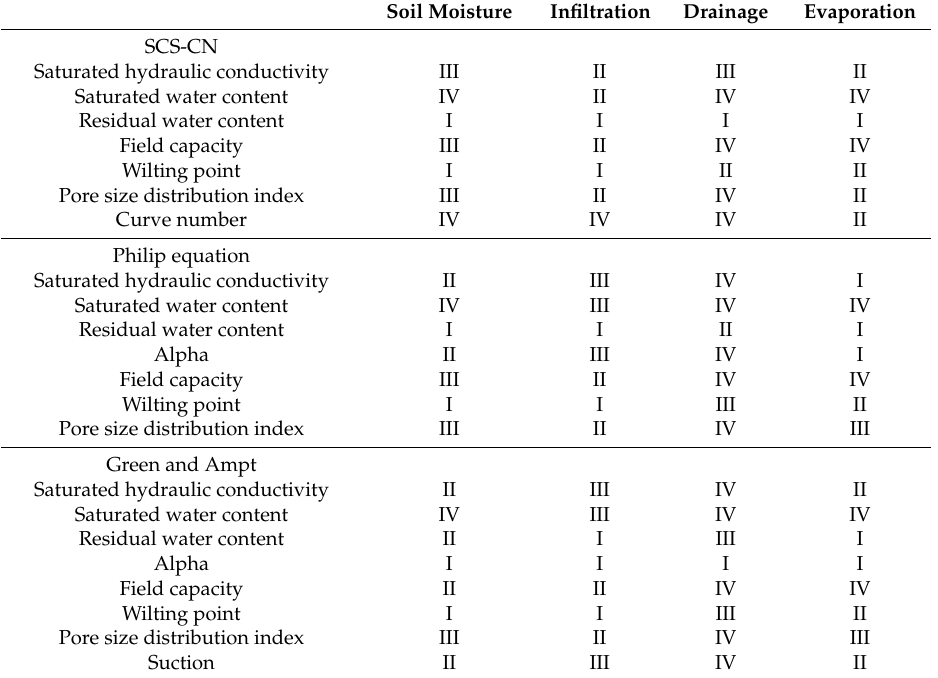
Table 4. Sensitivity of SCS-CN Philip and Green and Ampt models’ output to soil hydraulic input parameters.